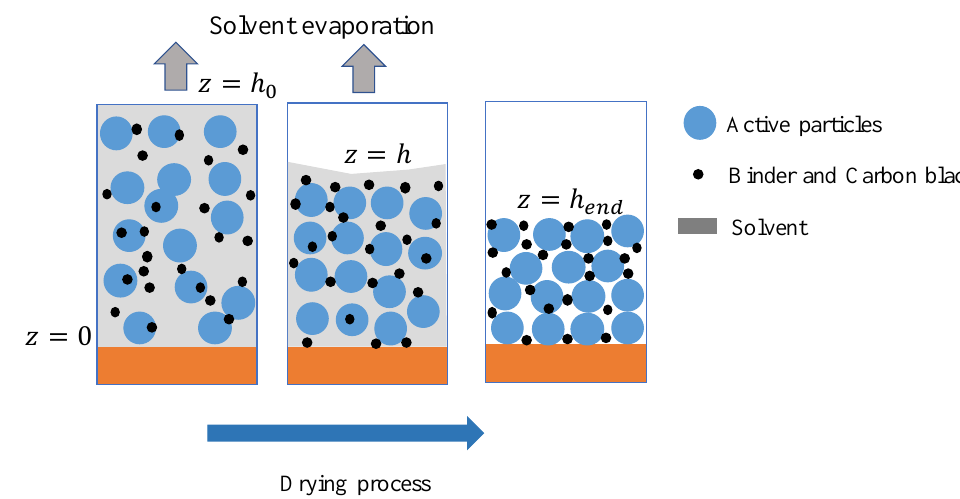
Figure 1. Illustration of a composite electrode film during drying process.